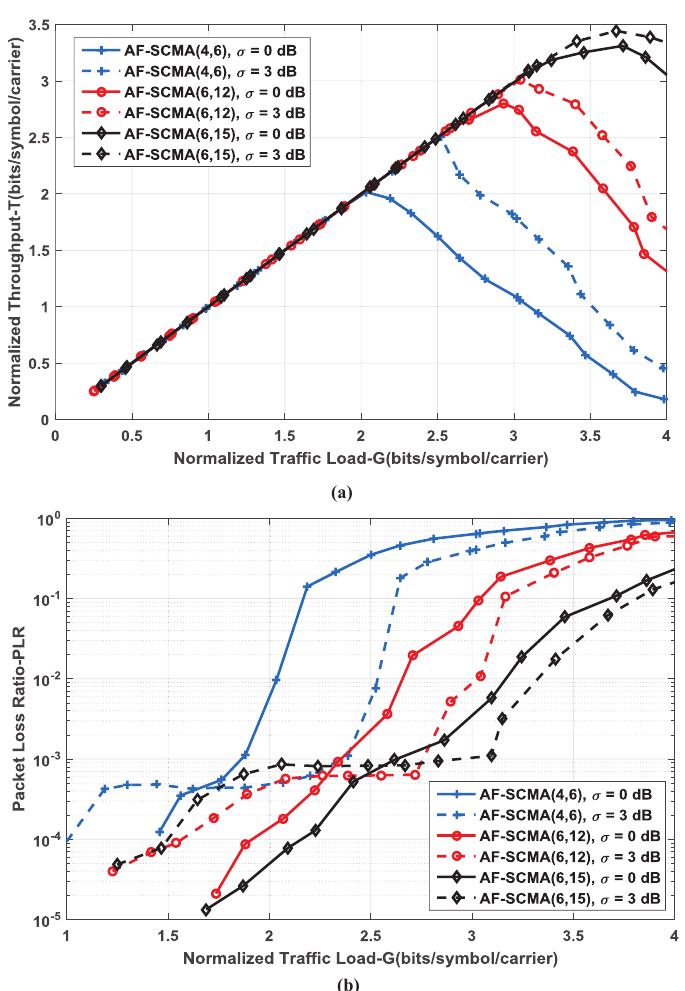
Figure 5. AF-SCMA performance comparison for packet size 500 bits, Turbo encoder with r = 1/3, = 13 dB, N = 10, N = 10, N = 6,12,15, number of subcarriers K = 4,6,6 in the [ E ] CB iter b / N 0 chunk D presence of power unbalance with µ = 0 and σ = 0,3 dB respectively. ( a ) Throughput. ( b )